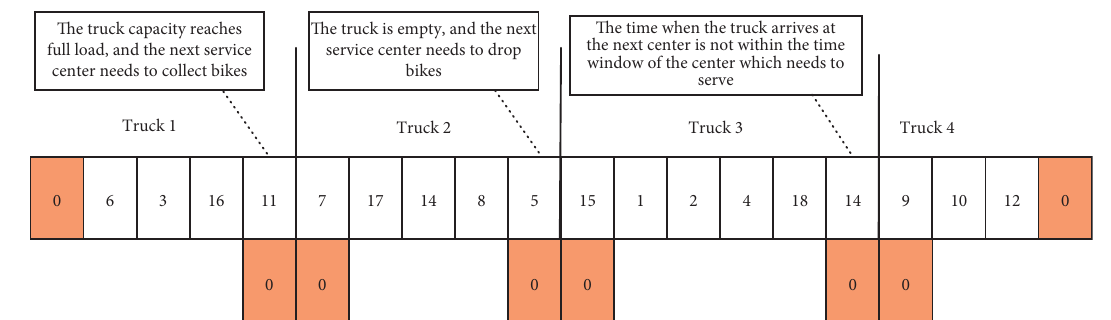
Figure 2: The conversion of demand point series into truck routes.